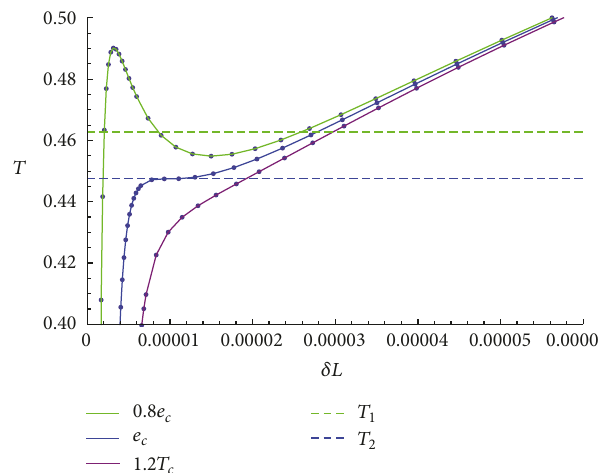
Figure 5: Relations between geodesic length and temperature for different 𝑒 with 𝑞 = 0.05 , 𝜃 0 = 0.1 .